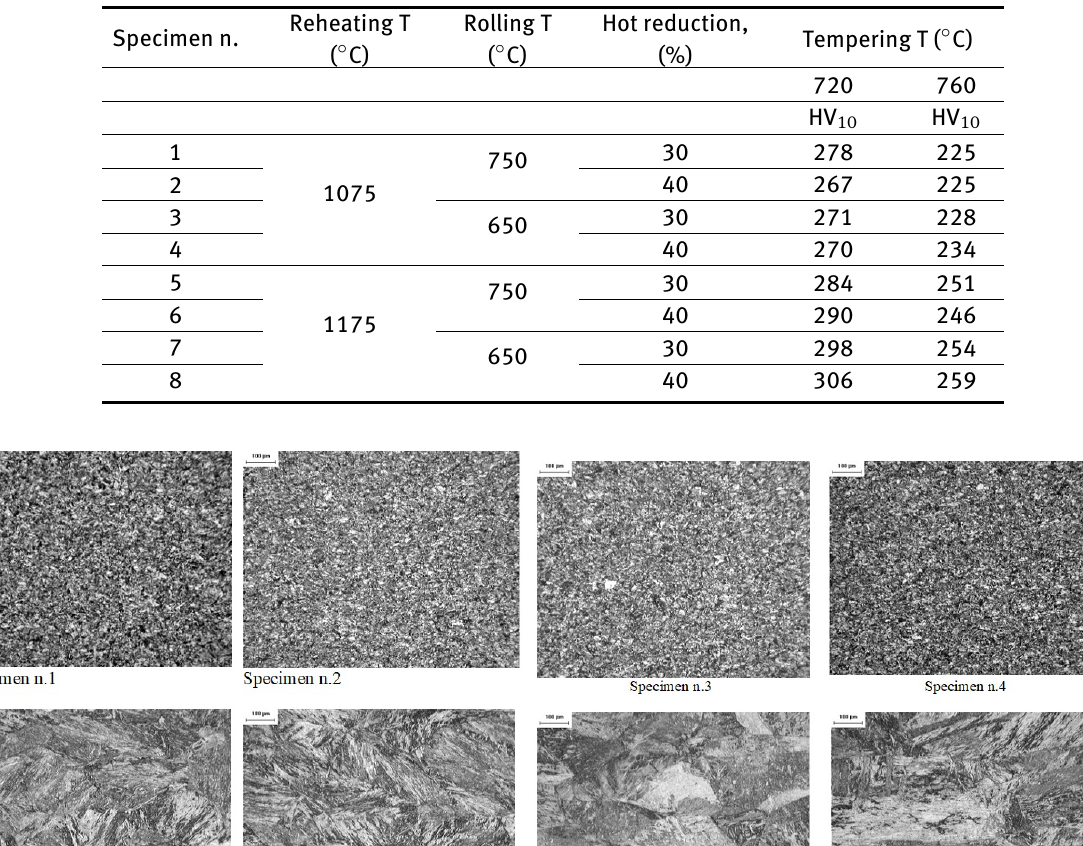
Table 2: Effect of tempering after hot rolling